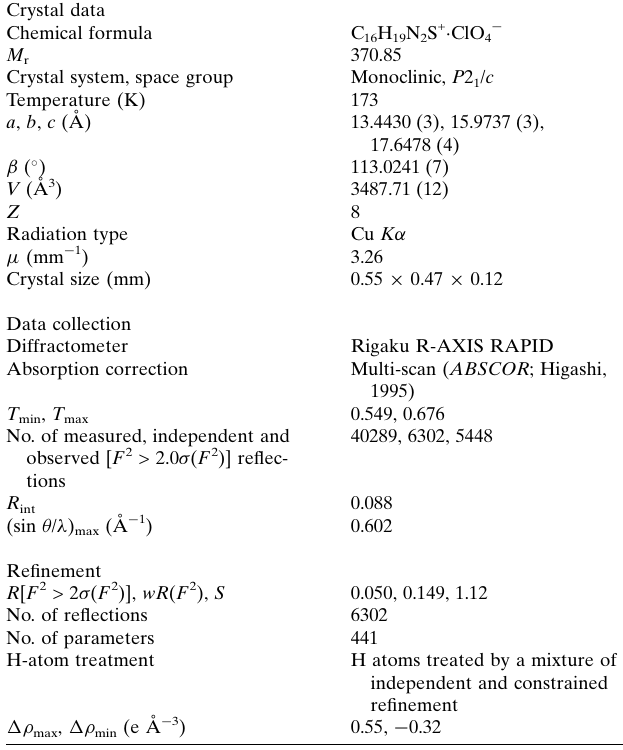
Table 1 Hydrogen-bond geometry (A˚ , (cid:4) ).